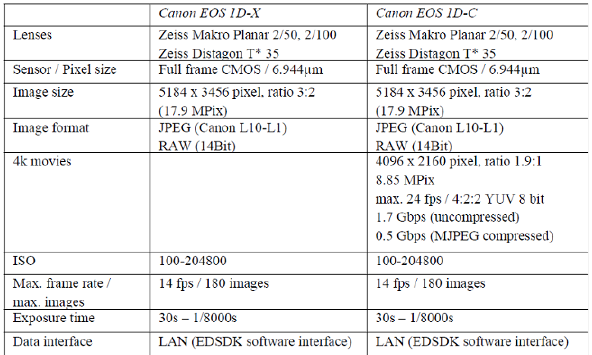
Table 2: Properties of the implemented CANON EOS cameras